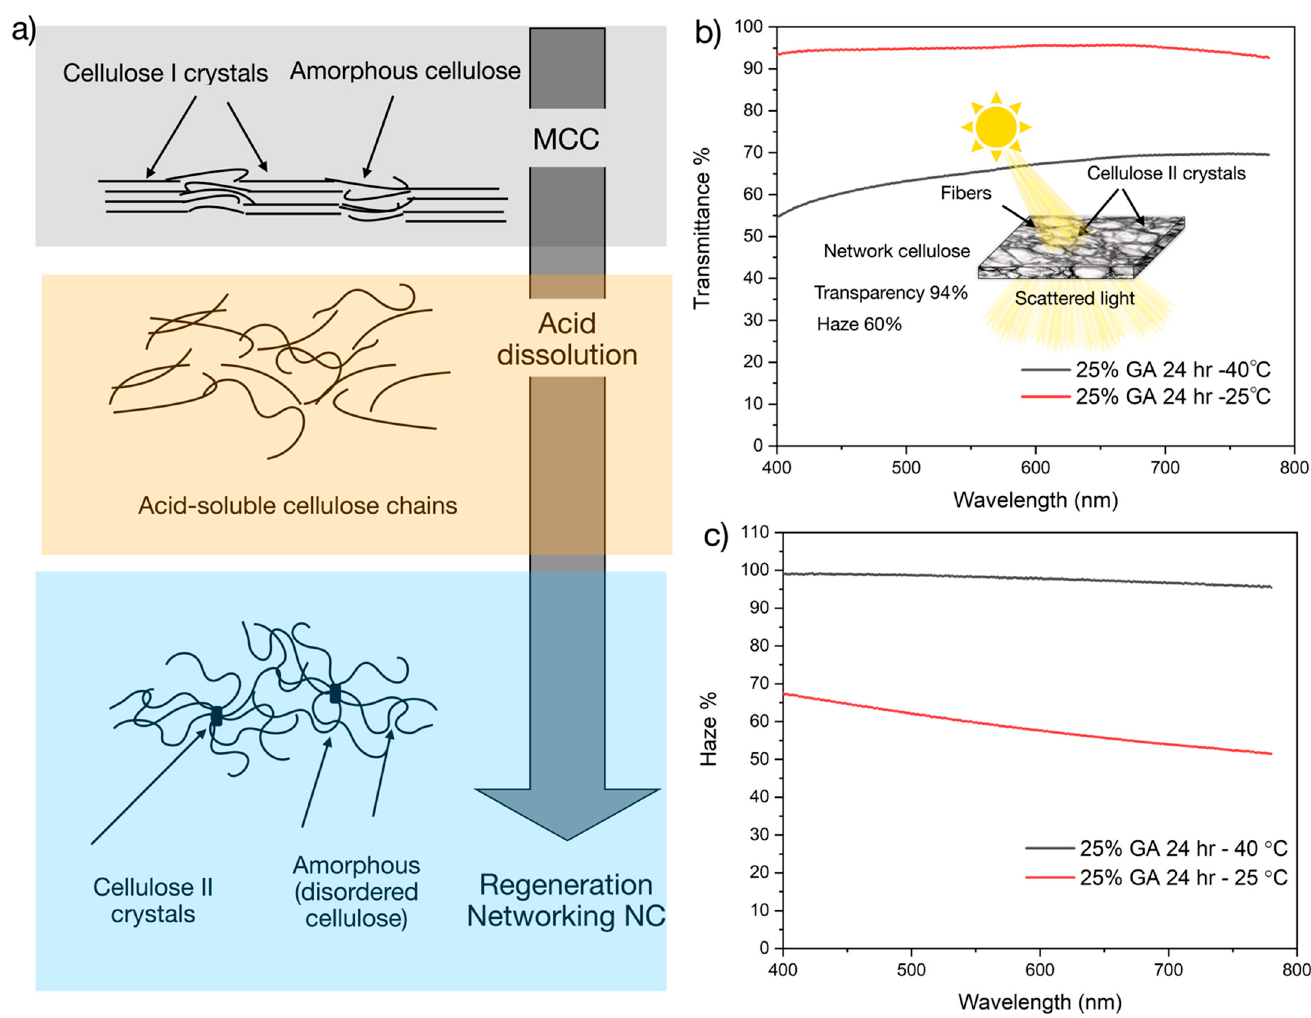
Figure 5. Optical properties of CRC cured at 25 °C and CRC cured at 40 °C. ( a ) Schematic representation of the suggested networking mechanism. ( b ) Transmittance and ( c ) transmission haze of CRC films cured at 25 and 40 °C, with sketch of haze representation in the inset of ( b ). ( d ) Digital images of laser light pointed at and scattered from CRC films cured at 25 and 40 °C. ( e ) Transparent and hazy CRC films cured at 25 and 40 °C, in close contact with and 1 cm above letters written to represent the films’ light transmittance and haze. ( f ) Transmission haze vs. optical transmittance of our CRC films in comparison with other reported cellulose-based transparent and hazy films.